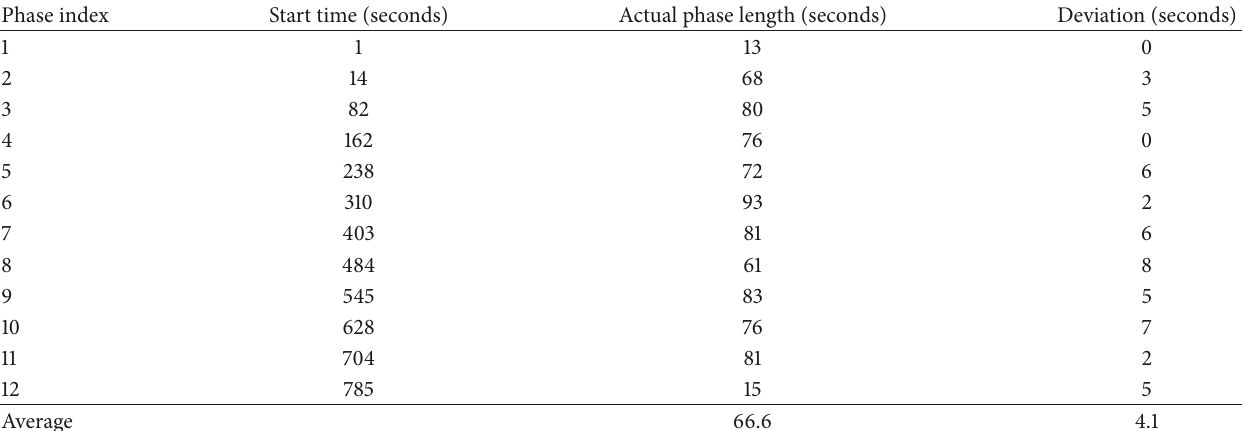
Table 8: An example of phase segmentation outputs for a test surgical workflow using FrameDiff GridBlock Kmeans method. Phase